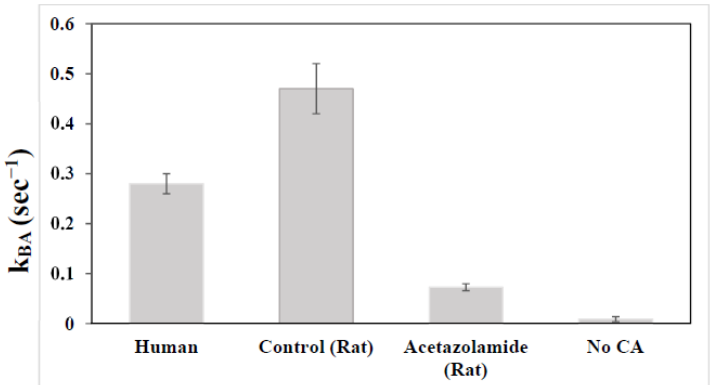
Figure 7. Pseudo first-order unidirectional bicarbonate dehydration rate constant k BA determined from healthy human subjects, control rats, rats treated with acetazolamide, and a phantom (standard deviation is plotted as error bars).